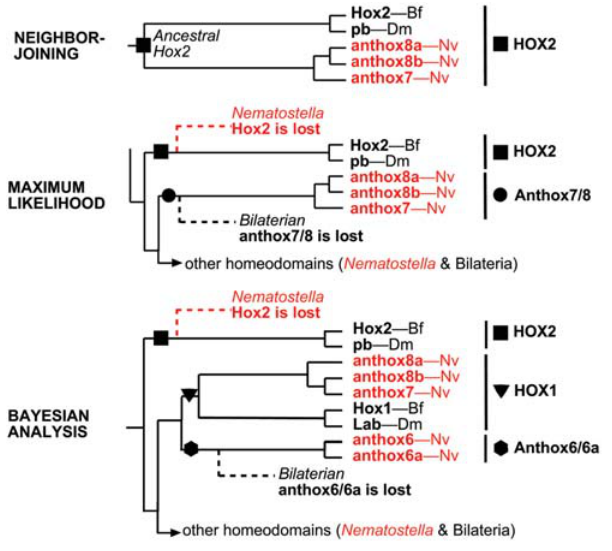
Figure 8. Reconstruction of Hox2 evolution. Portions of the neighbor- joining tree, the maximum-likelihood tree, and the Bayesian tree are redrawn here. The neighbor-joining tree implies that anthox7, 8a, and 8b are direct descendants of the ancestral Hox2 gene in the cnidarian- bilaterian ancestor. No gene loss is required. The maximum-likelihood tree implies that both a Hox2 precursor (square) and an anthox7/8a/8b precursor (circle) were present in the cnidarian-bilaterian ancestor. Hox2 was lost in the line leading to Nematostella , while anthox7/8a/8b ortholog was lost in the line leading to Bilateria. The Bayesian tree implies that a Hox2 precursor (square), a Hox1 parecursor (triangle), and an anthox6/6a precursor were present in the cnidarian-bilaterian ancestor. Hox2 was lost in the line leading to Nematostella , while anthox6/6a was lost in the line leading to Bilateria.